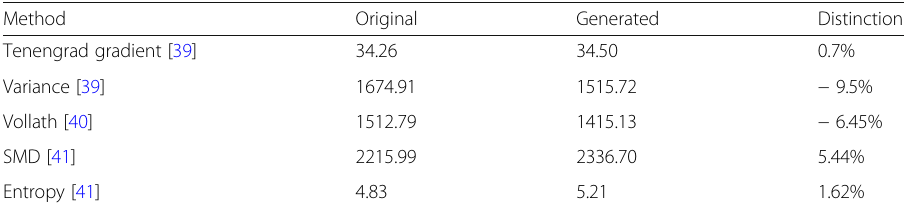
Table 1 Image quality evaluation Method